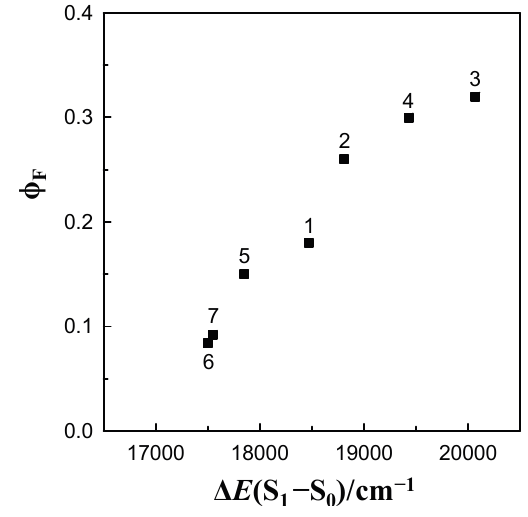
Figure 5. Correlation between the fluorescence quantum yield, Φ F , and the ∆ E (S 1 –S 0 ) = ν energy gap for 6AC in (1) acrylonitrile, (2) propionitrile, (3) DBE, (4) THF, (5) DMF, (6) DMSO, (7)